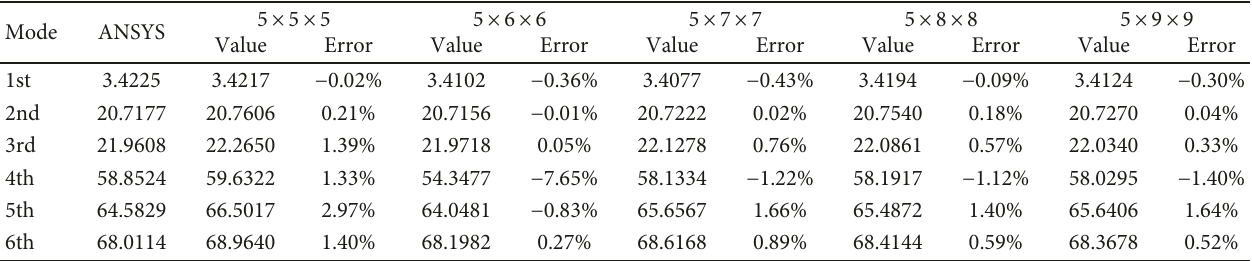
Table 1: Convergence of nondimensional frequency parameters for the fi rst six modes of the homogeneous material blade ( l = 3 , h = 20 , and θ = 15 ° ).